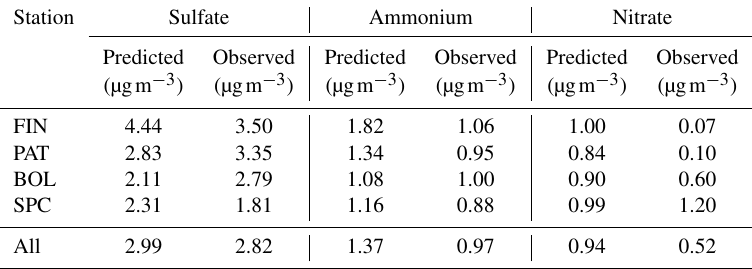
Table 4. Predicted (PMCAMx-UF) and observed (AMS) average PM 1 concentrations of sulfate, ammonium, and nitrate in different locations for base case